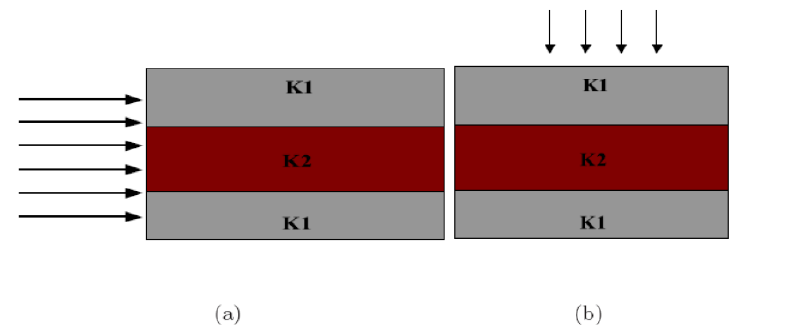
Figure 12. A layer cake-like permeability distribution with alternate layers of low permeability, shown in gray color and high permeability shown in red color, ( a ) with flow occurring from left to right along the layers and, ( b ) with flow occurring from top to bottom across the layers.